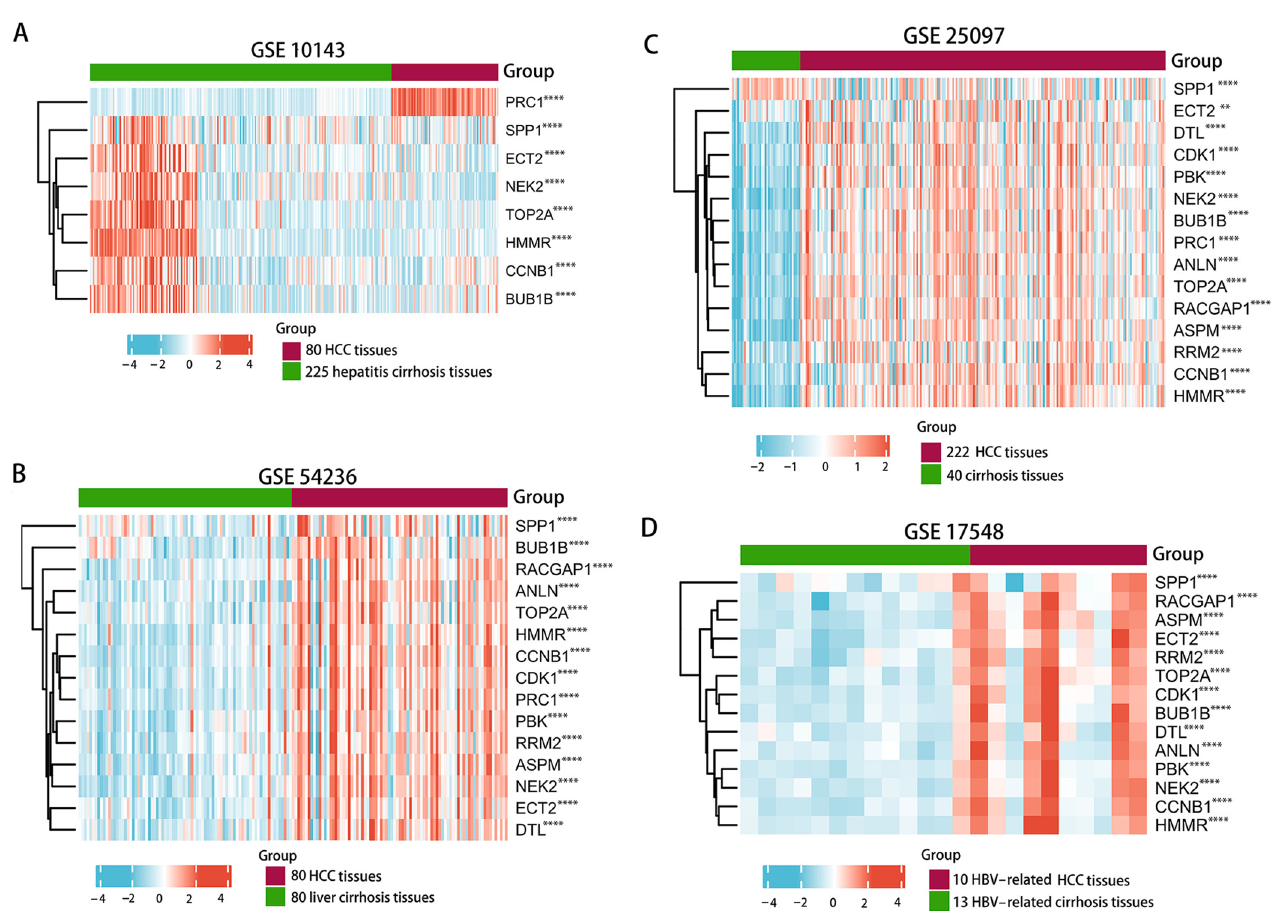
Figure 6. Expression validation of 15 up-regulated hub genes between liver cirrhosis and HCC tissues in the GEO database. HCC tissue group vs. cirrhosis tissue group in GSE10143 ( A ), HCC tissue group vs. cirrhosis tissue group in GSE54236 ( B ), HCC tissue group vs. cirrhosis tissue group in GSE25097 ( C ), and HBV-related HCC tissue group vs. HBV-related cirrhosis tissue group in GSE17548 ( D ). Green and red represent cirrhosis and HCC samples, respectively. GEO, Gene Expression Omnibus. ** P <0 .01, **** P <0 .0001.